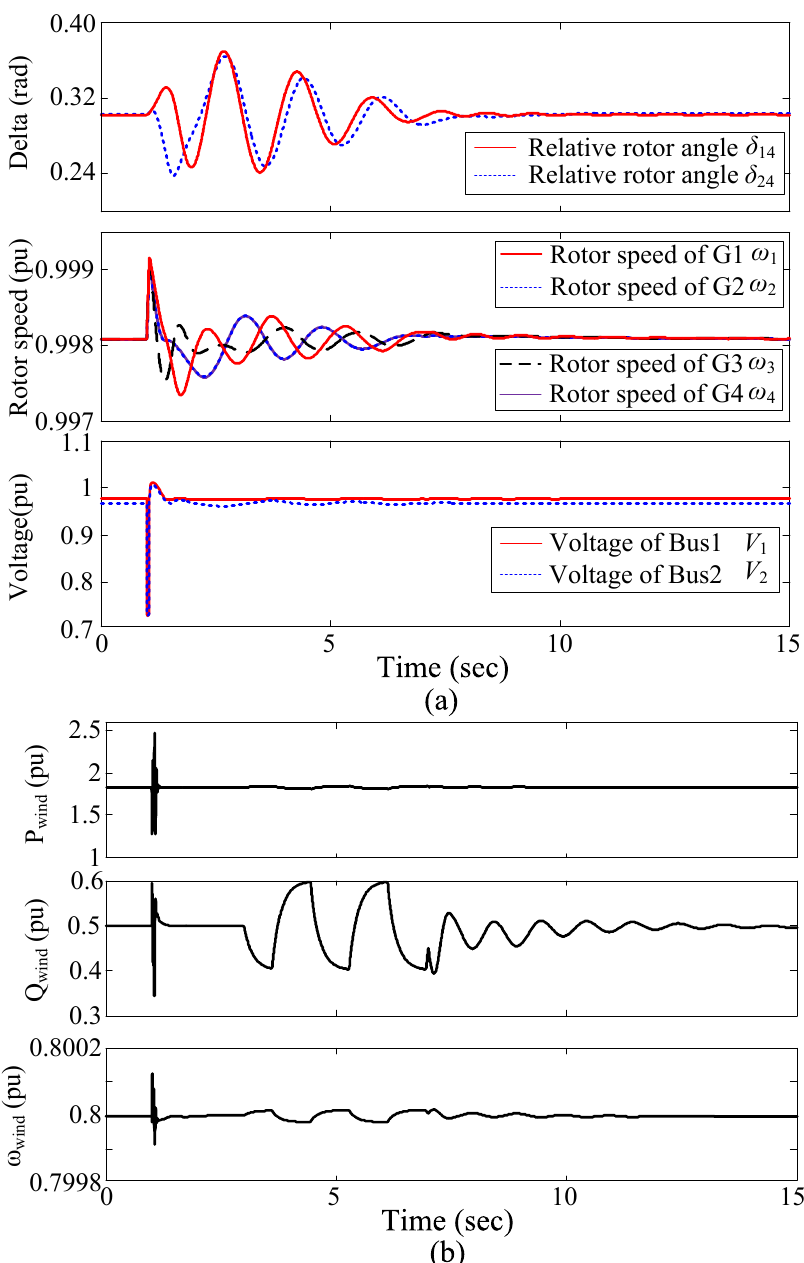
Figure 9. System dynamic performances with damping controller added to reactive power feedback control loop. ( a ) Generators dynamics, from top to bottom: δ 14 and δ 24, rotor speeds of the generators, buses voltage; ( b ) DFIG dynamics, from top to bottom: active power of DFIG, reactive power of DFIG, and rotor speed of